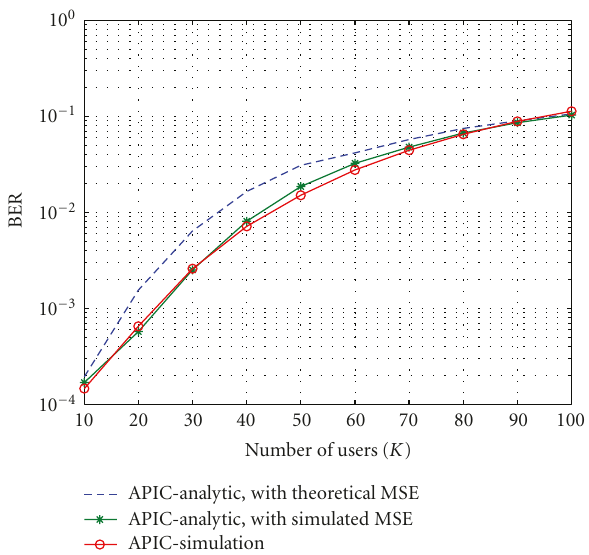
Figure 5: Analytical and simulation results of the one-stage CPIC and APIC receivers, N = 32, K = 30. APIC-analytic uses the simu- lated